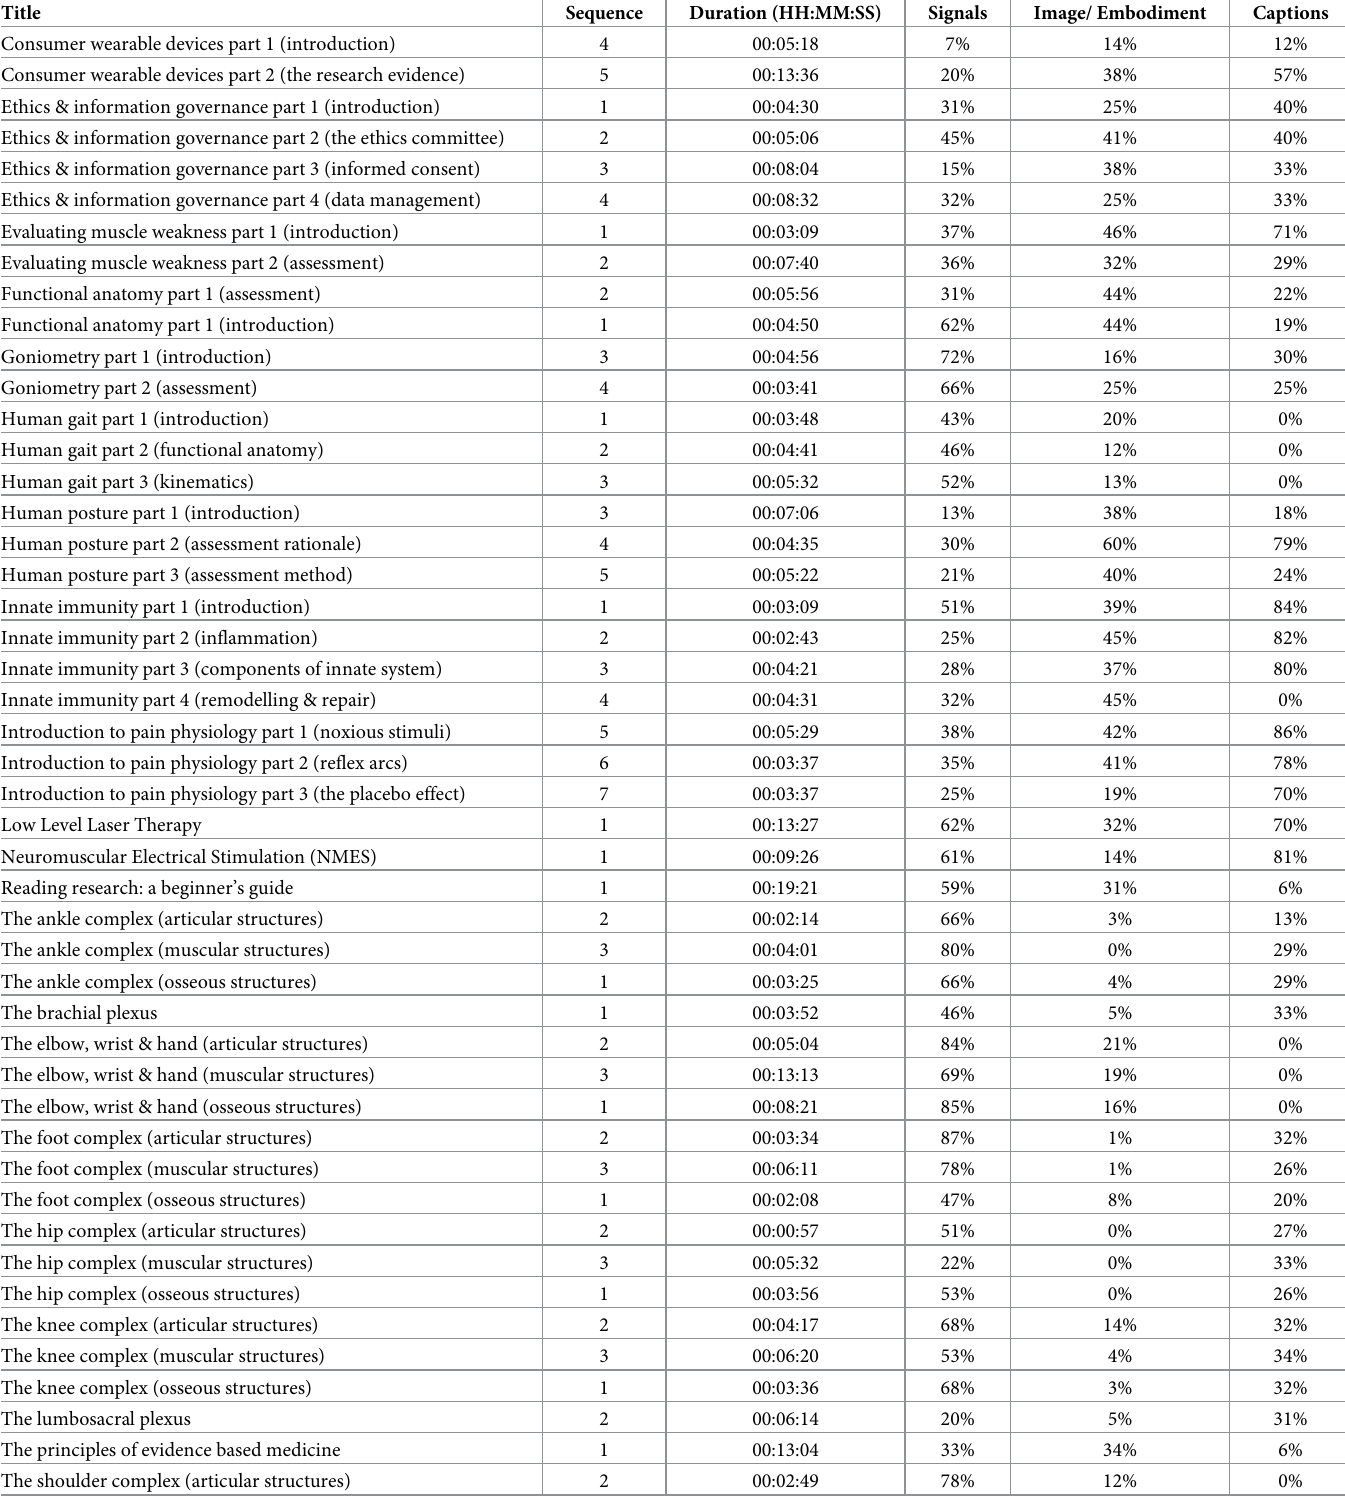
Table 2. Characteristics of video lecture